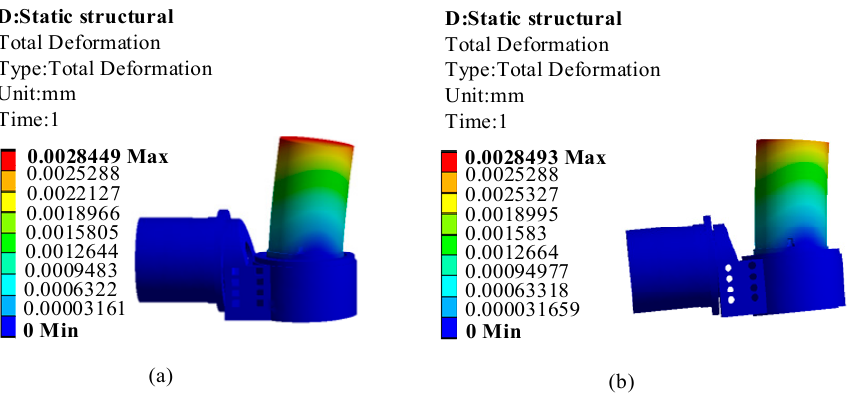
Figure 22. Deformation nephogram of direct-drive turntable with different swing frames in milling working condition: ( a ) opening square hole; ( b ) opening round hole.